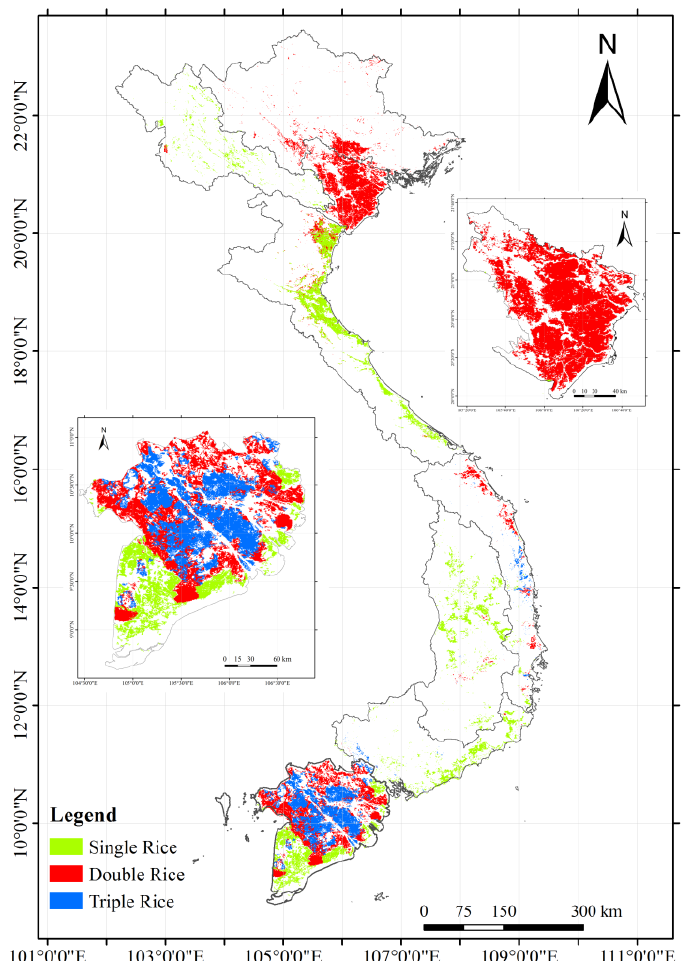
Figure 7. Result of rice cultivation area extraction using DTW-based similarity measure.